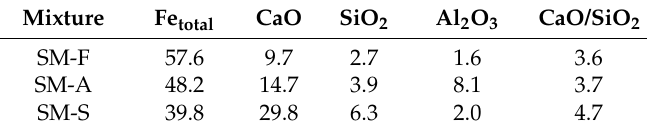
Table 9. Estimated chemical composition of the adhering layers, wt %.